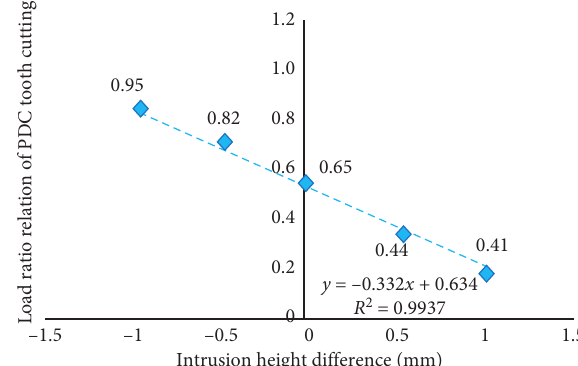
Figure 5: Load ratio relation of PDC tooth cutting with intrusion height difference under two cutting